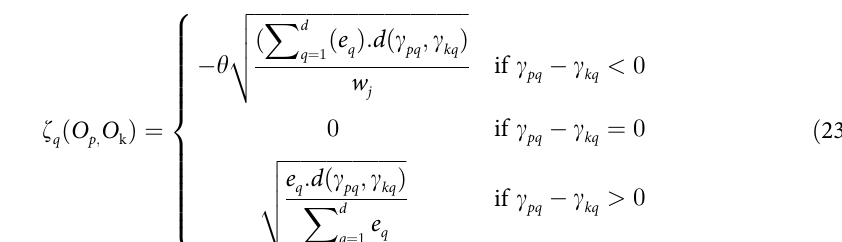
and normalized group score q